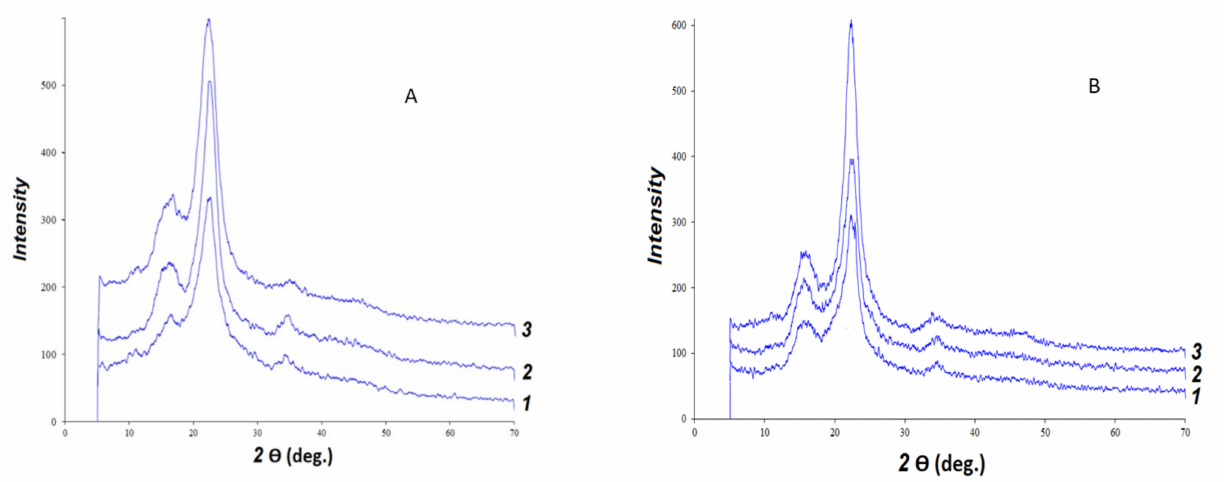
Figure 6. Diffraction patterns of the samples birch wood ( A ): initial (1), alkali-treated (2), acid-treated (3) and of the solid products of catalytic hydrogenation of the birch wood ( B ): initial (1), alkali-pretreated (2) and acid-pretreated (3). Diffraction patterns of all the samples under study contain two peaks with maxima at 2 θ equal to 22.5 ◦ and 16 ◦ (Figure 6) assigned to reflections of atoms in plane (002) and overlapped reflections of atoms in planes (101) and (101 ) , respectively, of the